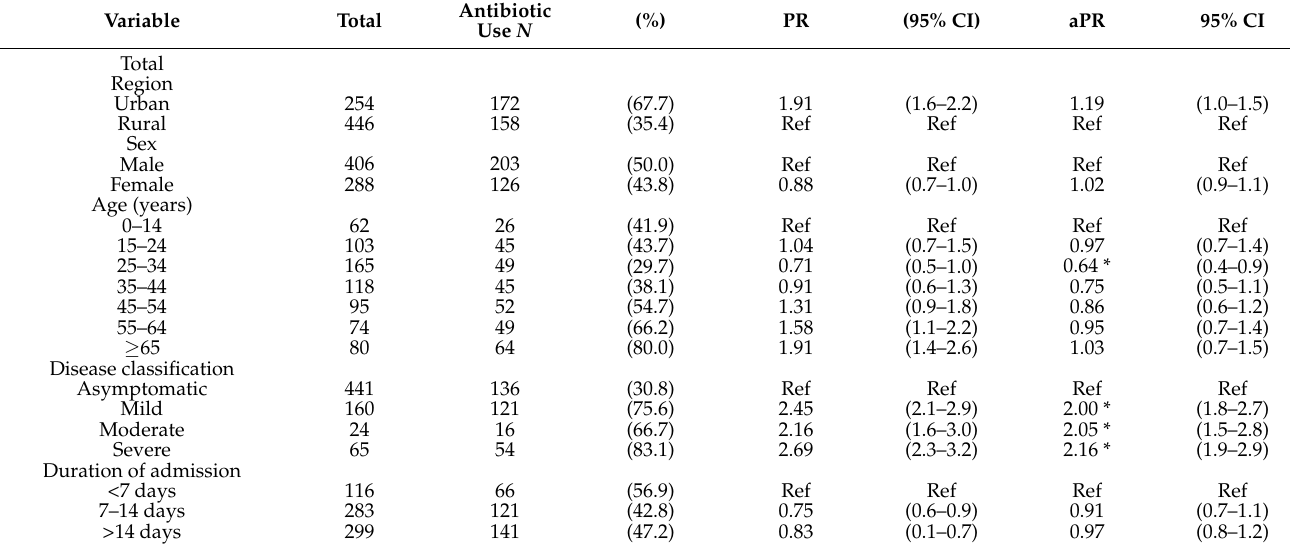
Table 3. Prevalence of antibiotic use and its associated factors among people with confirmed COVID-19 infection admitted in community care centres and treatment centres of Sierra Leone,